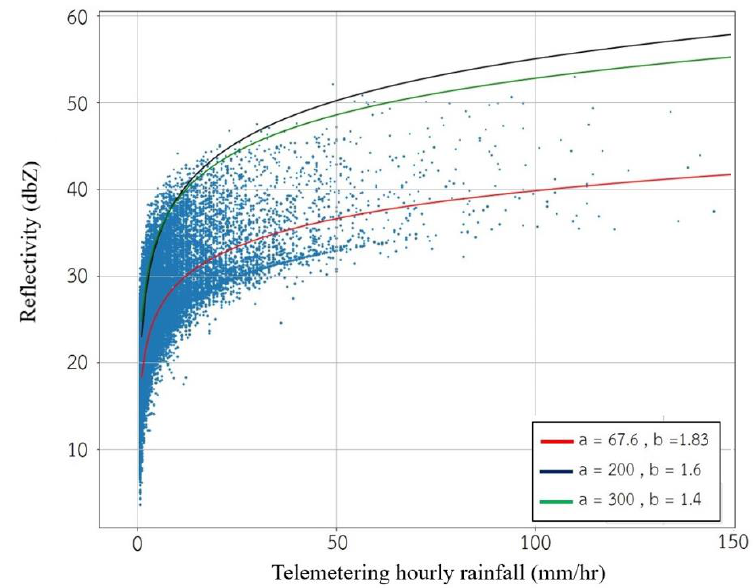
Figure 6. The distribution of the telemetered rainfall rate (rain gauge data), with reflectivity for Marshall Palmer Stratiform (blue line), Summer Deep Convection (green), and Linear Log Regression (red). Data are for the years 2018 and 2019.